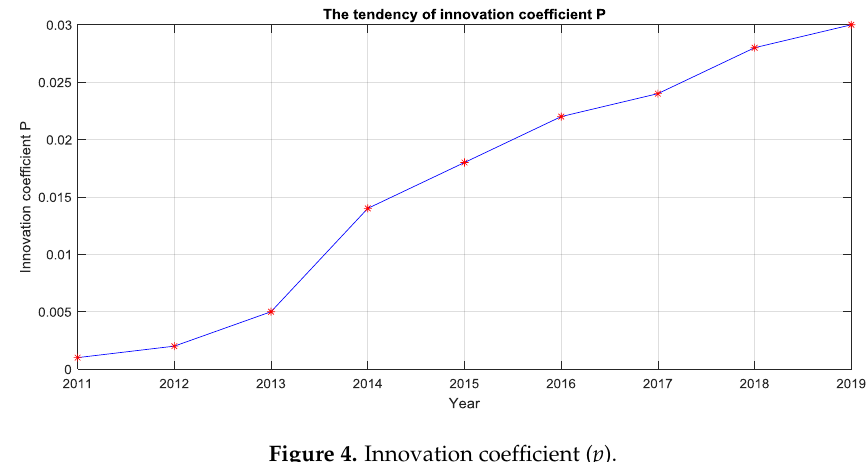
Figure 4. Innovation coefficient ( p ).